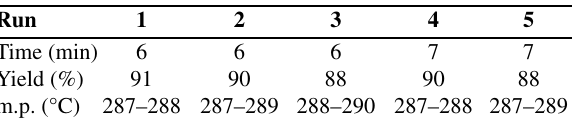
Table 3. Evaluation of reusability of the ionic liquid for the synthe- sis of 3b Run